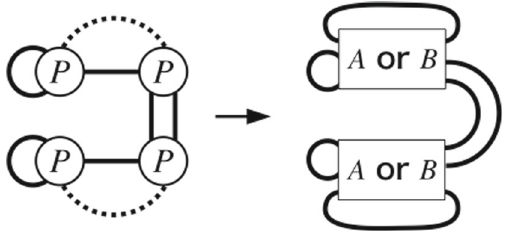
’s. This can be com- abc